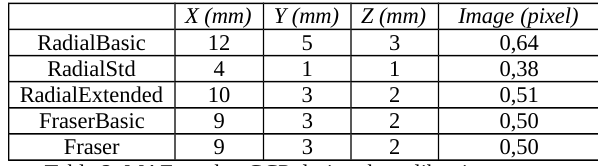
“Figee” : Freeze the calibration parameters in the bundle adjustment